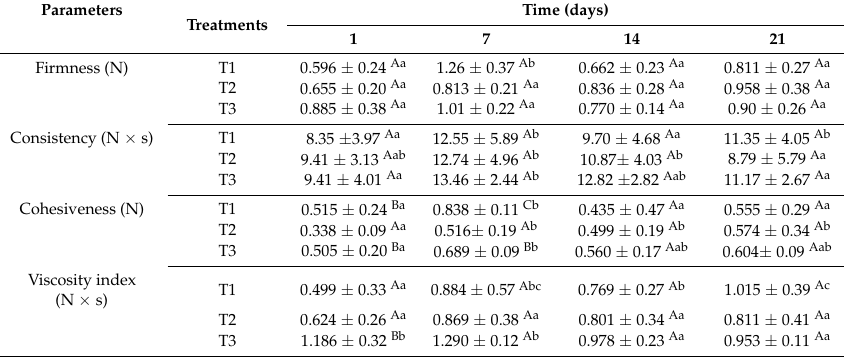
Table 5. Instrumental firmness, consistency, cohesiveness* and viscosity index* of fermented